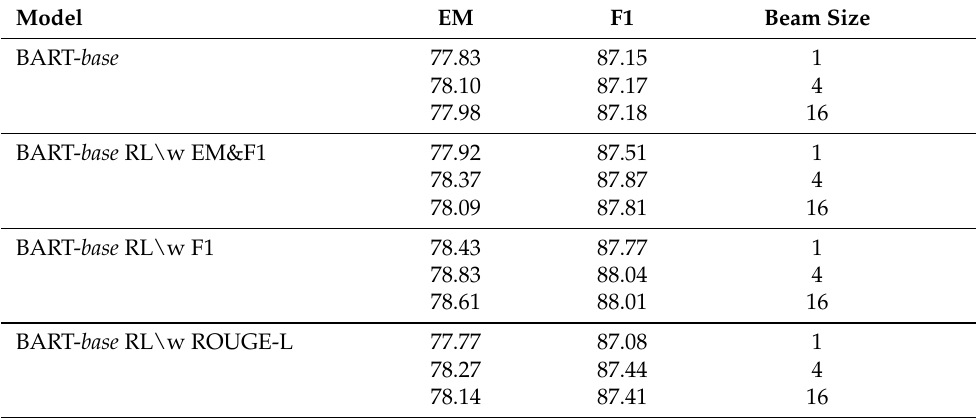
Table 4. The experiment results with different beam sizes. Model